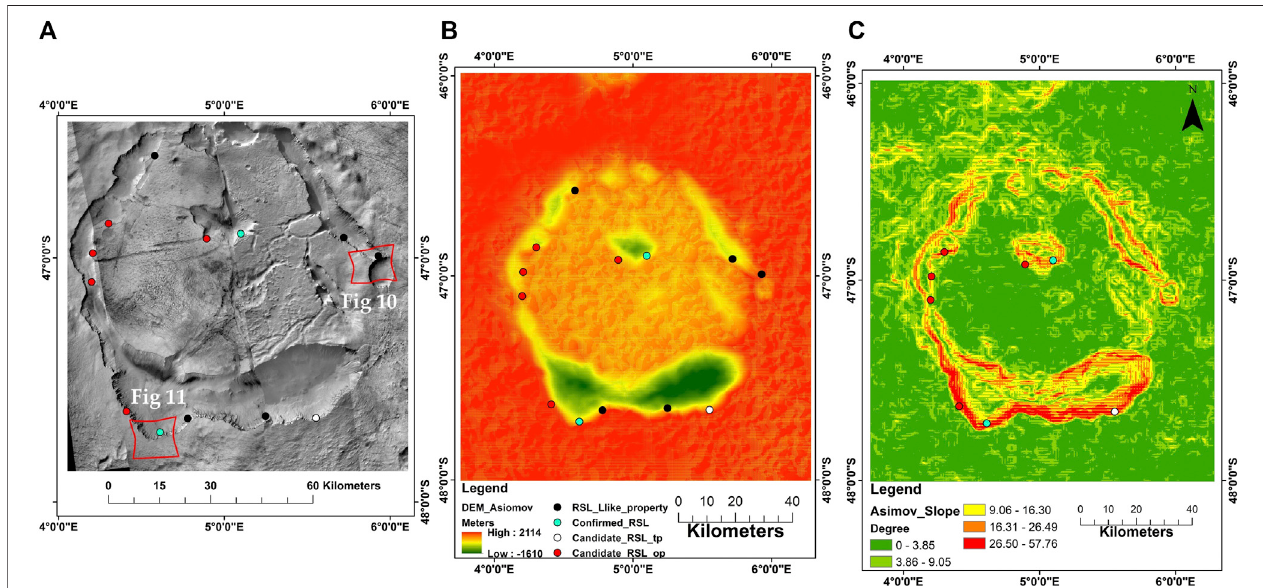
FIGURE 2 | Asimov Crater, (A) CTX mosaic, (B) MOLA DEM and (C) Slope map. Red polygons are footprint of CRISM data coverage in the scene.